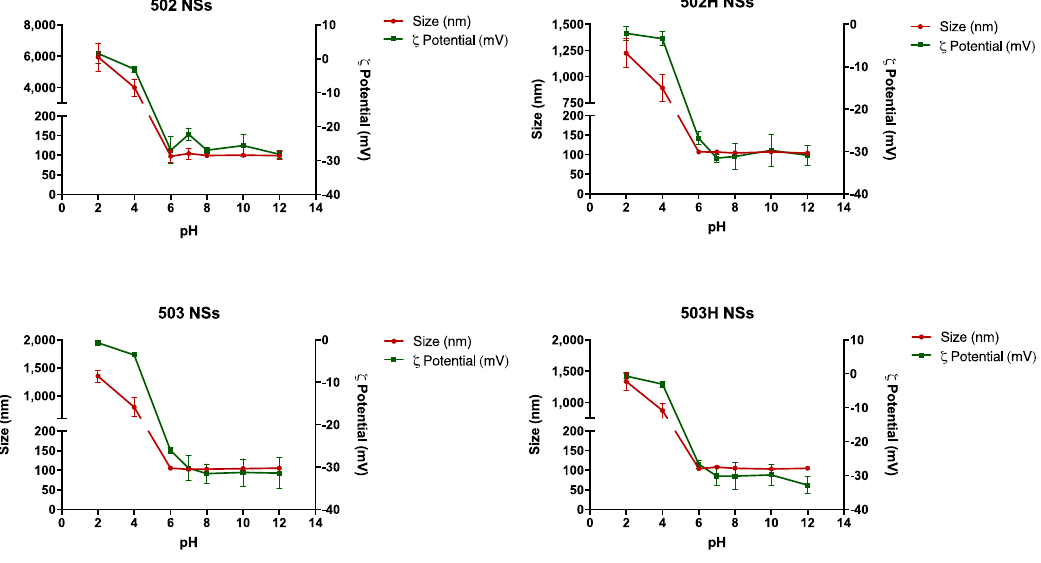
Figure 10. Changes in size and ζ potential values of lactoferrin-loaded PLGA NSs over the studied ionic strength interval.